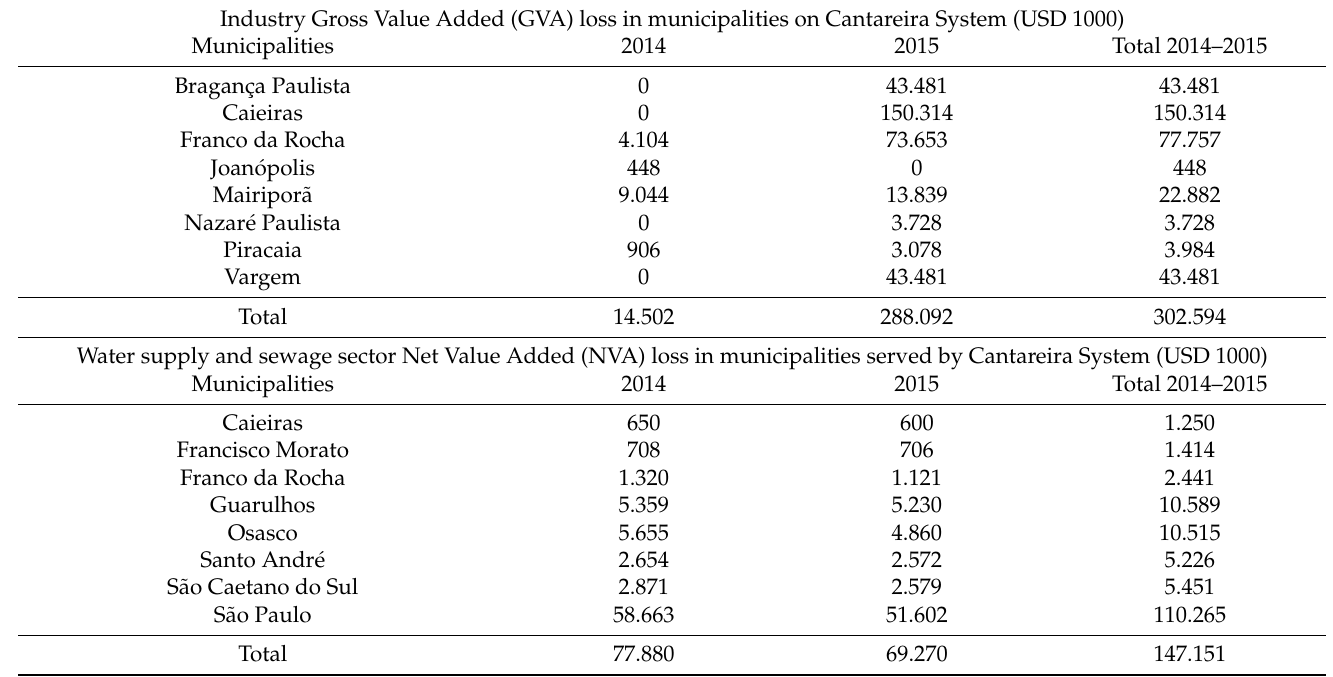
Table 1. Estimated economic losses associated with 2014–2015 drought